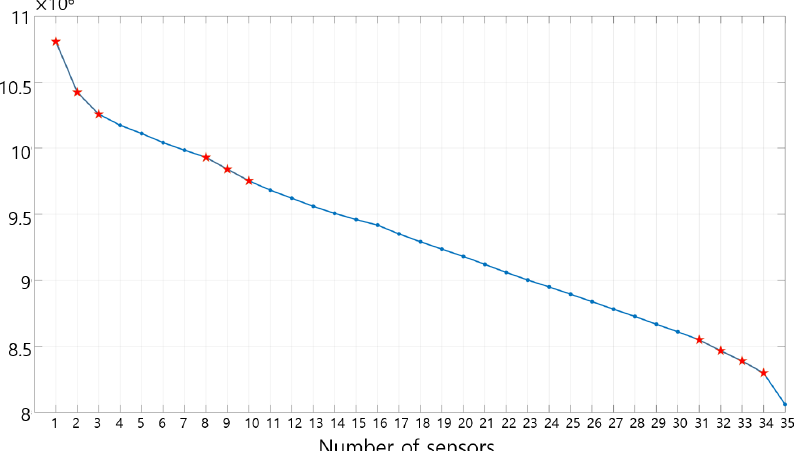
Figure 12. Averaged magnitude of the reflected wave from ‘one’ sensor (rearranged in order from the largest value of the averaged amplitude).